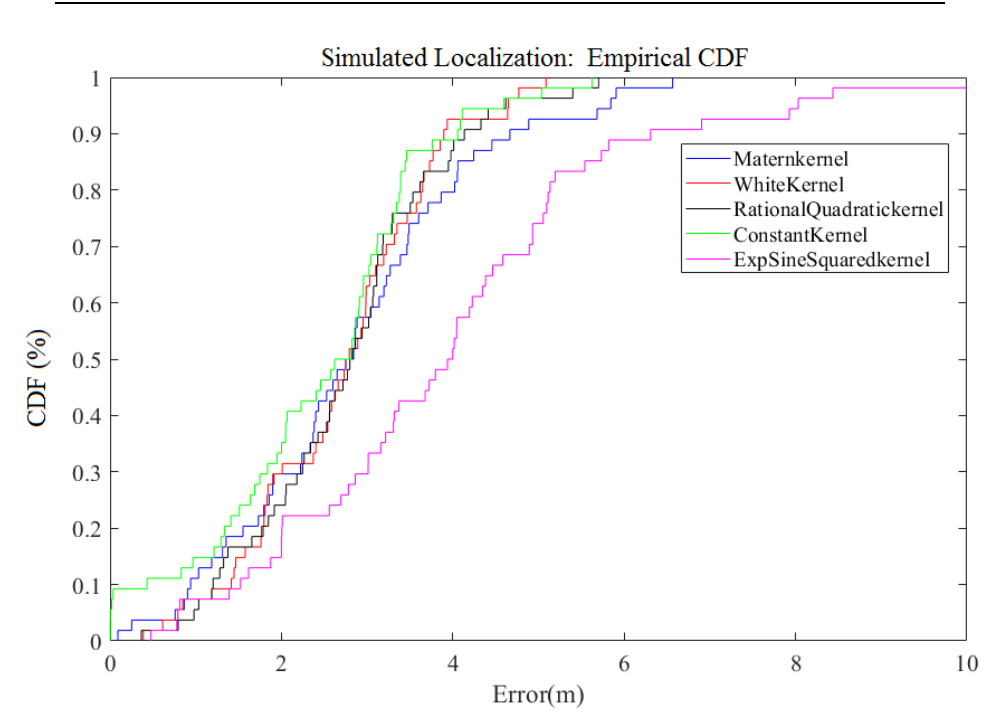
Figure 6. The CDF Comparison for Simulated localization error of different kernels.